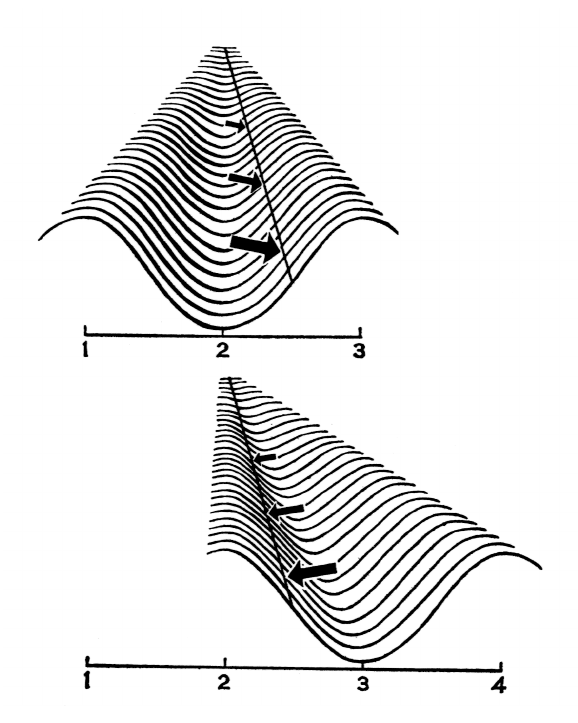
A Diagram of ‘Genetic Assimilation,’ from Conrad H. Waddington, The Nature of Life (London: Allen